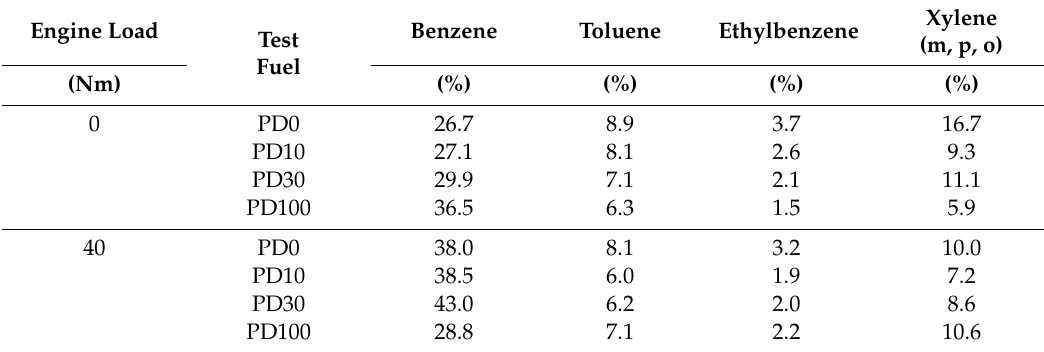
Figure 6. Toxic aromatic VOCs, BTEX: engine load of ( a ) 0 Nm, and ( b ) 40 Nm. Table 10. BTEX results under different test conditions.